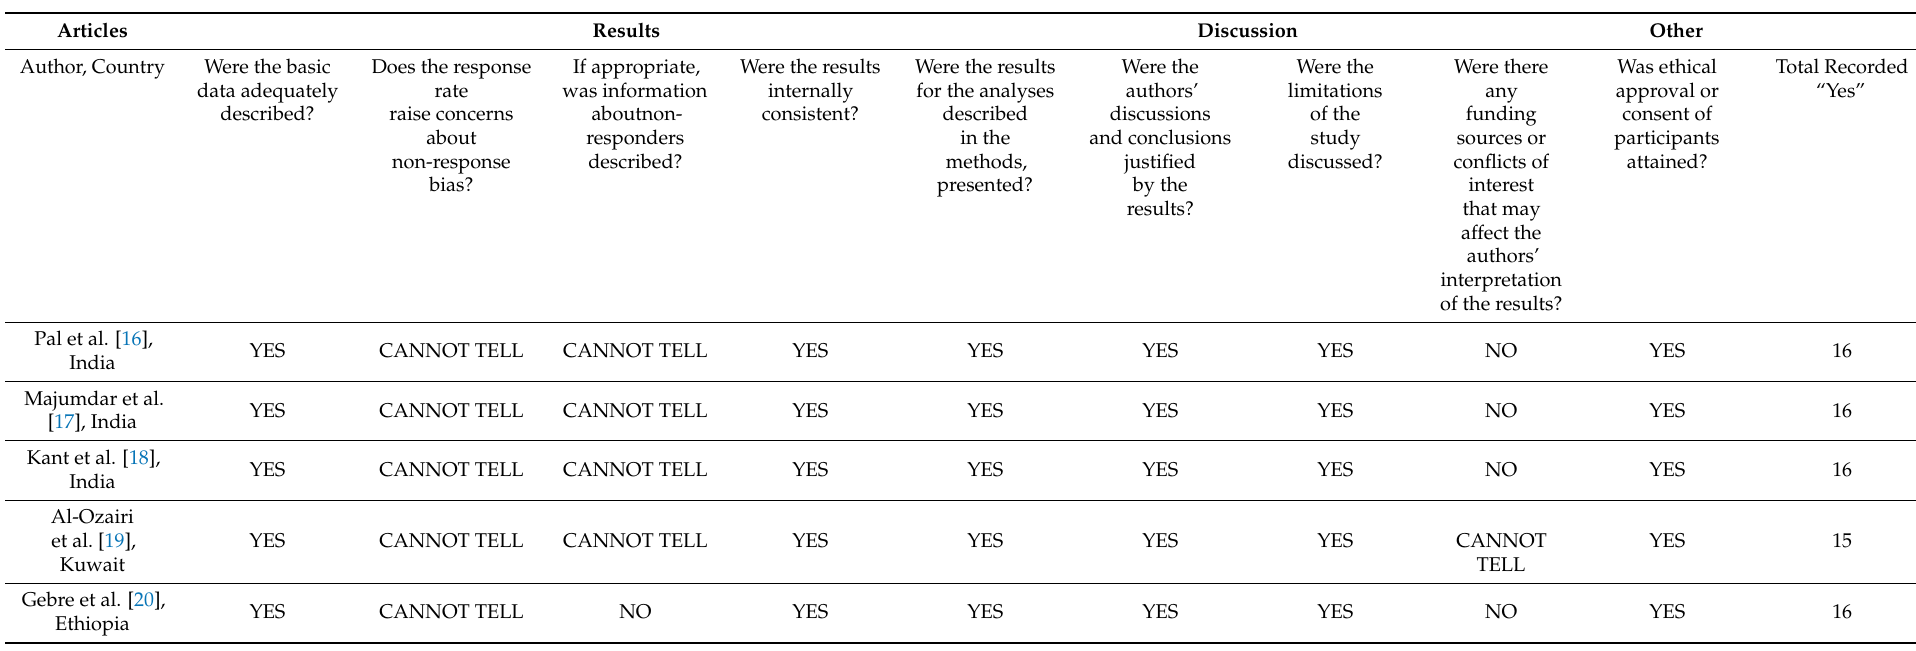
Table A2. Quality assessment of included studies using the AXIS